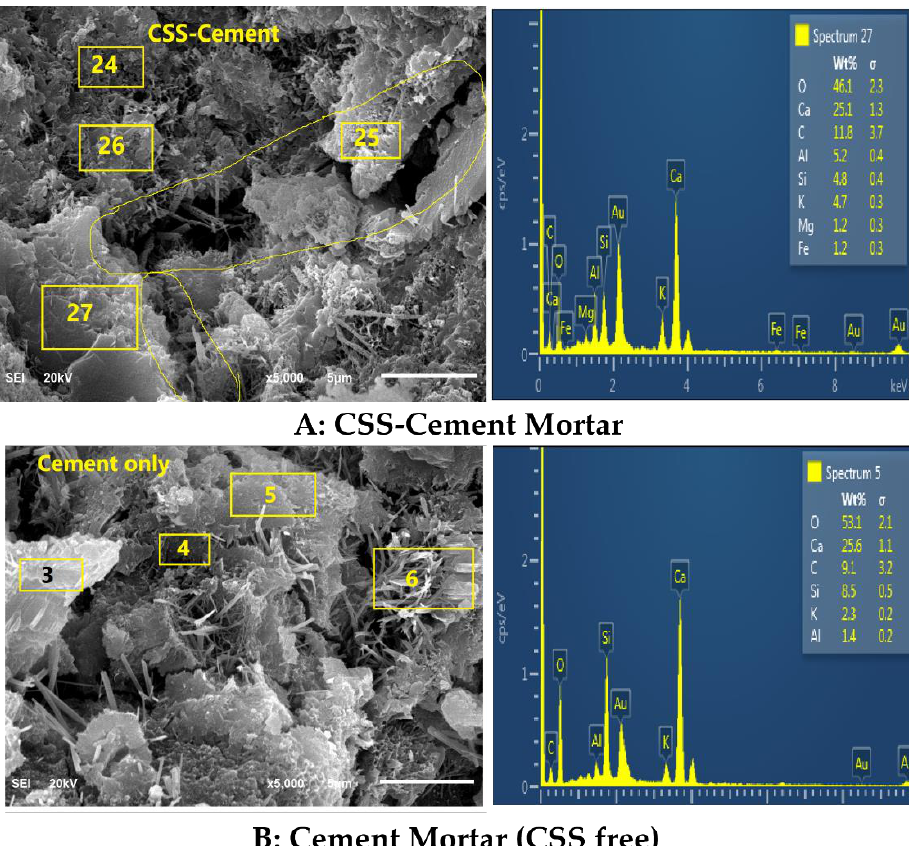
Figure 9. Morphology of CSS-blended mortars ( A -top) and OPC mortar ( B -bottom).